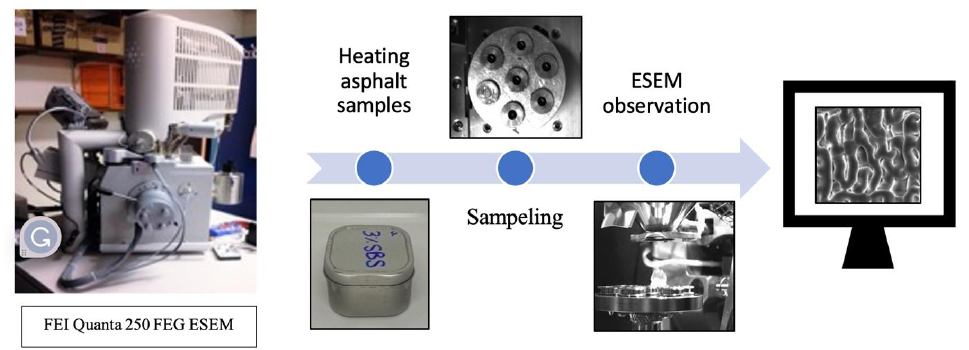
Figure 7. ESEM (FEI Quanta 250 Figure 7 . ESEM (FEI Quanta 250 FEG) .